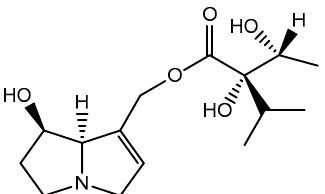
Figure 4. Chemical structure of intermedine, an ester of monocarboxylic acid.